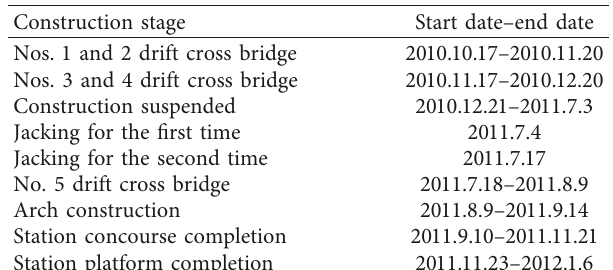
Table 2: Construction